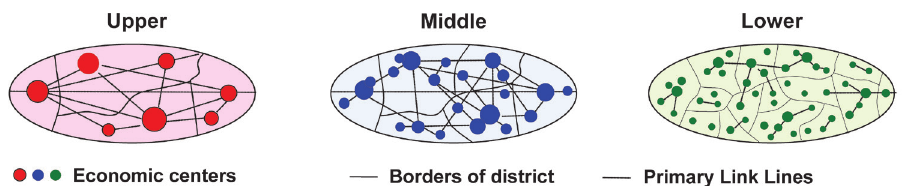
Figure 2. Conditional schemes of territorial organization of three layers of the economy according to F. Brodel. The illustrations are suggested by the author of this